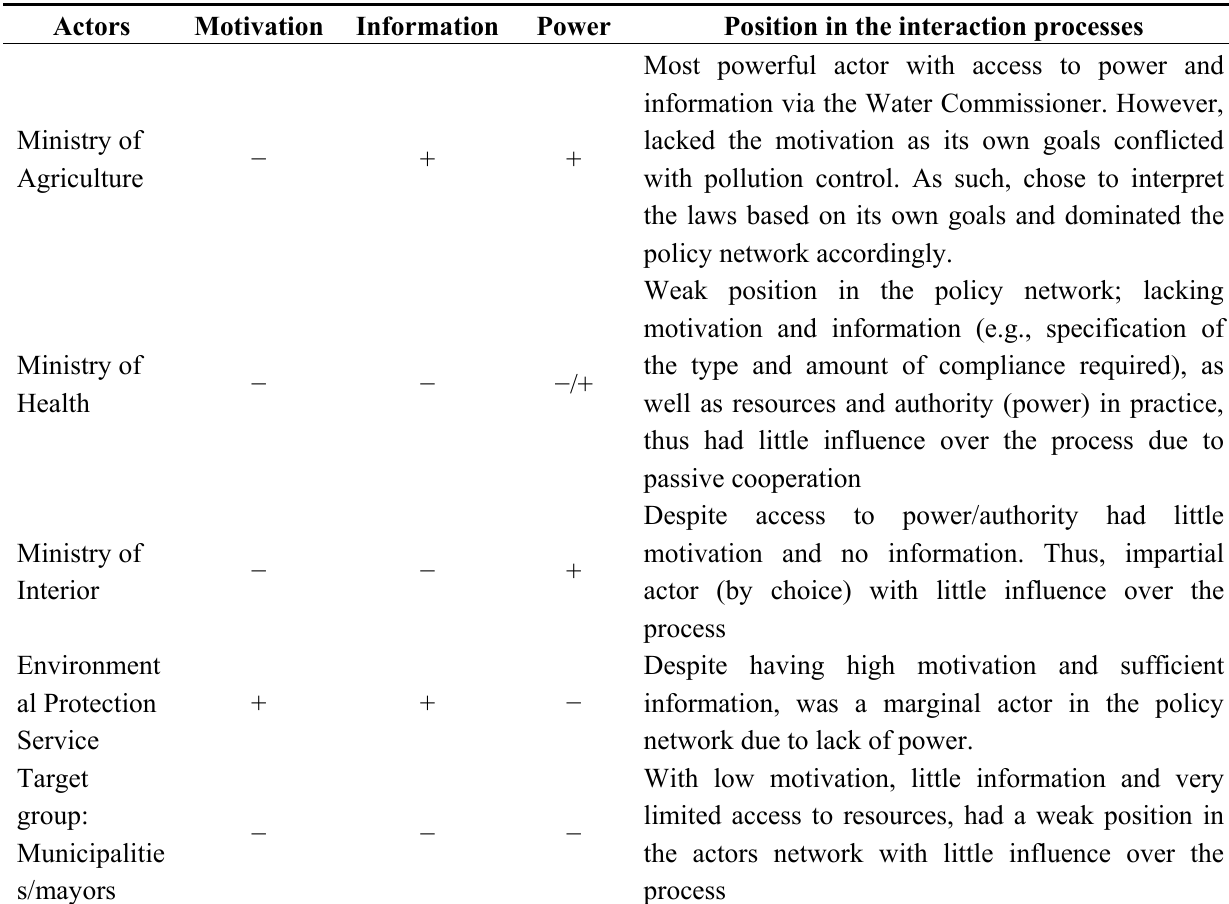
Table 3. Characteristics and interaction processes, key actors; 1948–1989 (lack of